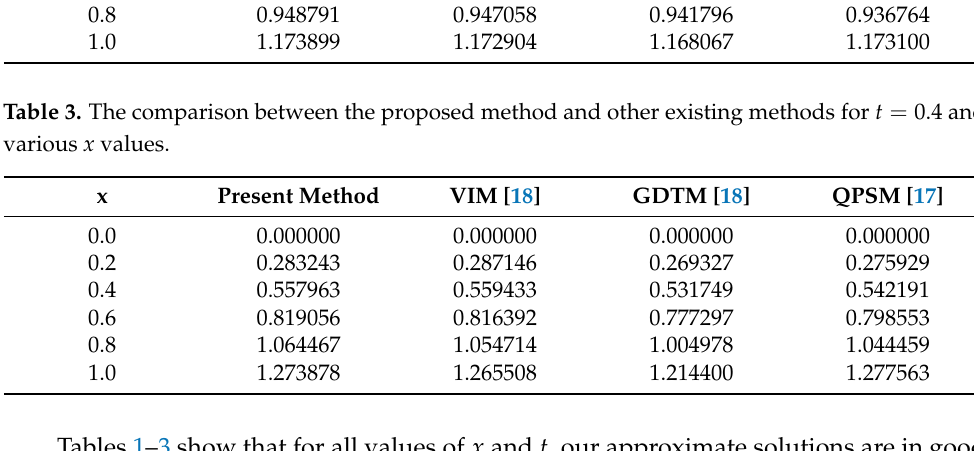
Figure 2. Graphs of the approximate solutions 𝑊(cid:4666)𝑥 , 𝑡(cid:4667) for 𝑡 (cid:3409) 0.5 (cid:4666)ℎ (cid:3404) 0.0125, 𝑘 (cid:3404) 0.0005(cid:4667) . 5. Conclusions